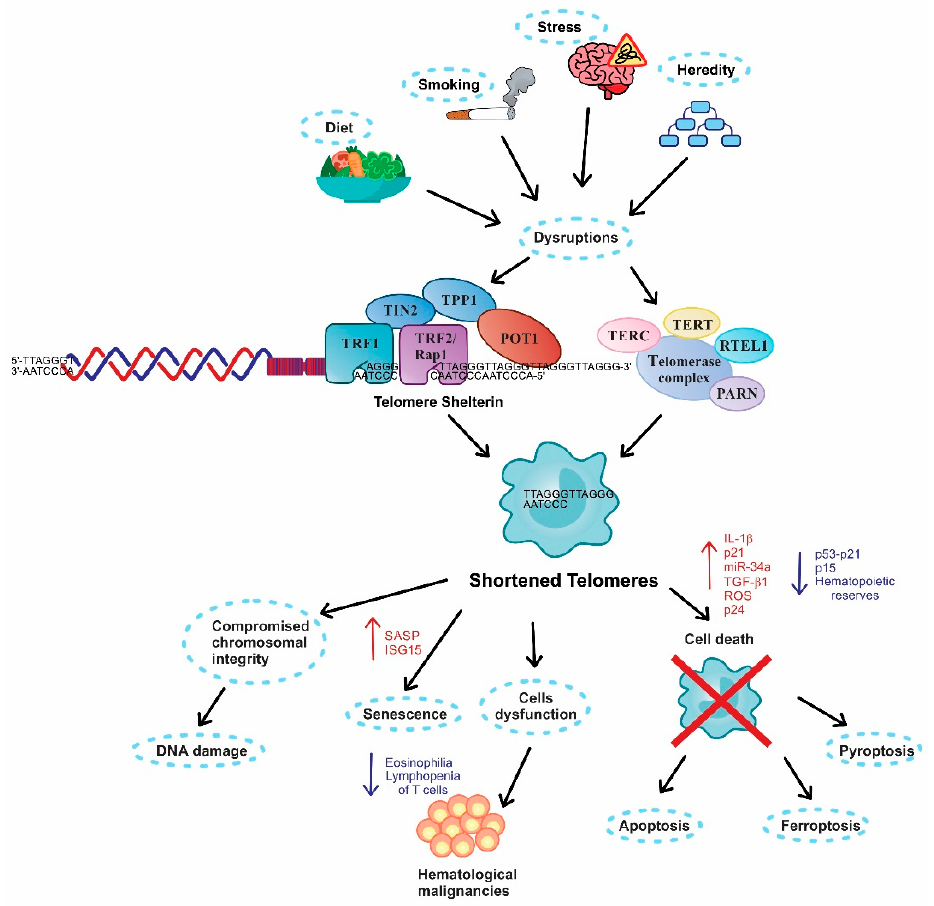
Figure 2. Schematic of accelerated telomere shortening—causes and its biological consequences. Insults by environmental or genetic factors induce disruptions in one of two essential complexes that regulate the telomere length: (1) telomere/shelterin, integrated with TRF1 (telomeric repeat factor 1), TRF2 (telomeric repeat factor (2), RAP1 (repressor/activator protein (1), TIN2 (TRF1-interacting nuclear factor (2), TPP1 (tripeptidyl peptidase (1), and POT1 (protection of telomeres 1) and (2) telomerase complex, composed by TERC (telomerase RNA component), TERT (telomerase reverse transcriptase), RTEL1 (regulator of telomere elongation), and PARN (gene encoding poly(A)-specific ribonuclease) proteins. These disruptions induce rapid telomere shortening (TS) (upper panel). Consequently, TS promotes the loss of chromosomal integrity and DNA damage, enabling an inflammatory microenvironment disbalance characterized by high levels of IL-1b, ROS, and TGF-b1 (lower panel). This figure was done with CorelDRAW Graphics software.